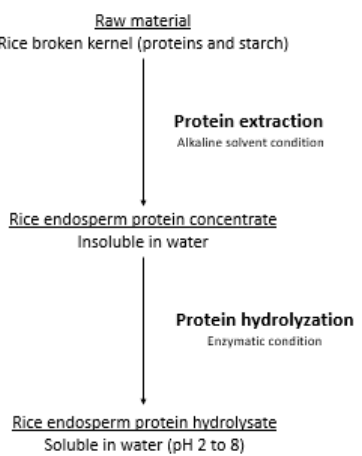
Figure 1. Structure of the rice grain. Nutrients 2020 , 12 , x FOR PEER REVIEW